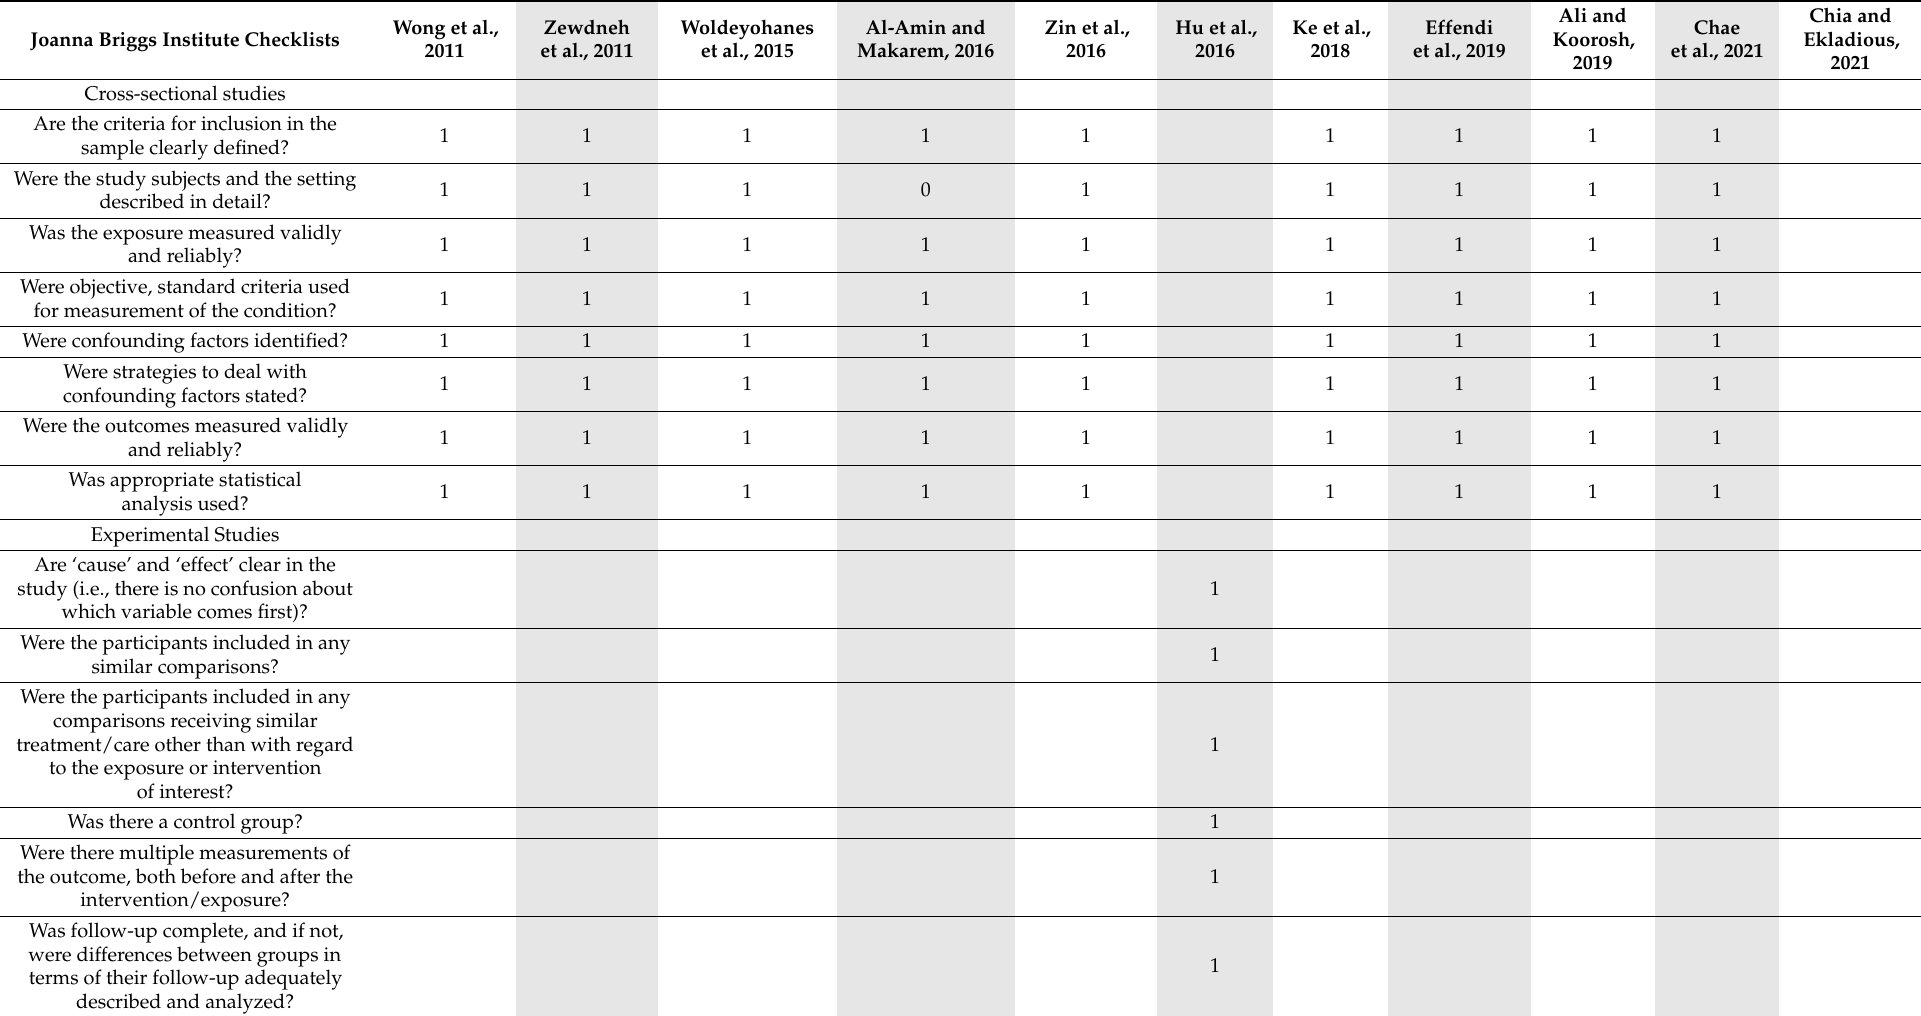
Table 5. Methodological Quality of Included